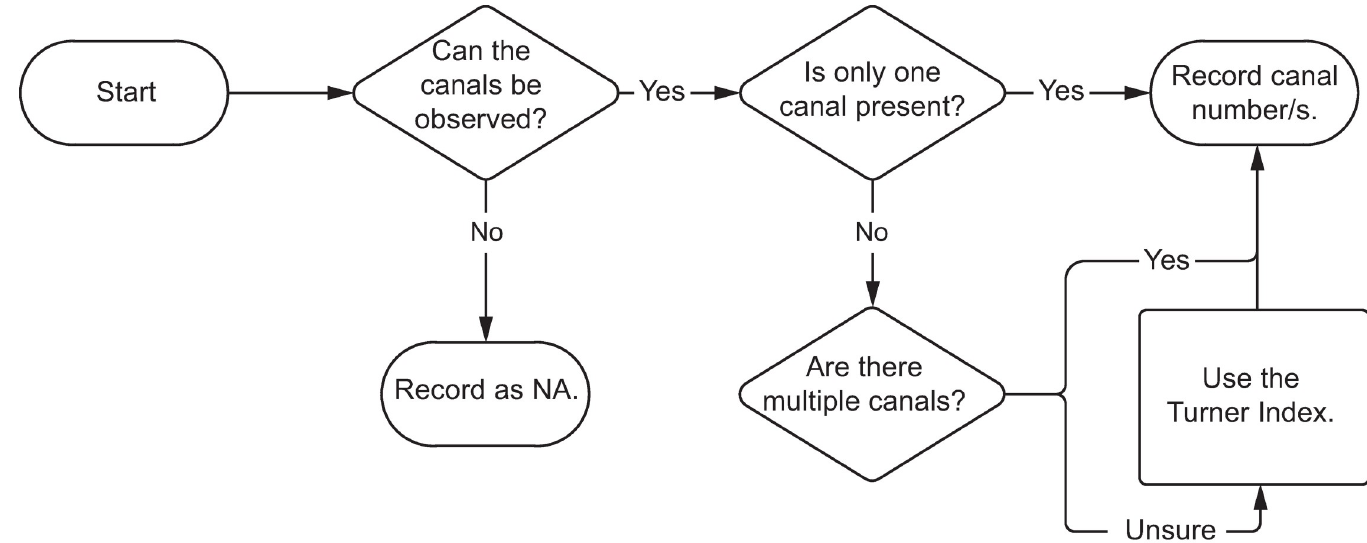
Fig 14. Flow chart for determining and recording phenotype element 2—canal number.